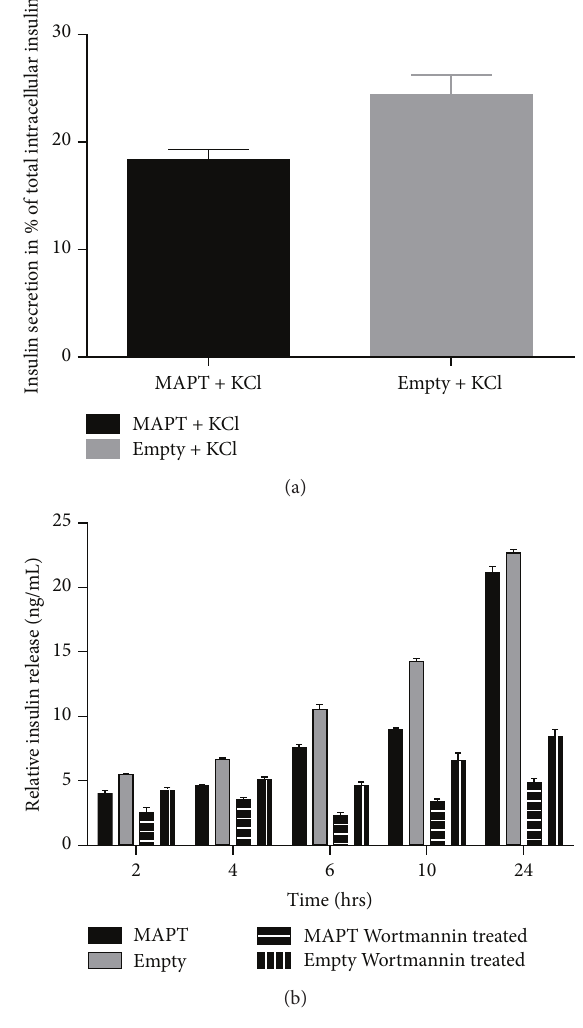
Figure 7: Insulin secretion. (a) Insulin secretion after stimulation for 2h with 20mM KCl. Insulin secretion from MAPT overexpress- ing cells versus Empty was calculated in the percentage of total intracellular insulin content; 𝑝 < 0.05 . (b) MAPT overexpressing Rin-5F cell line versus Empty over a time period of 24 hours. Cell lines were either grown in RMPI 1640 medium or in RMPI 1640 medium supplemented with 1 𝜇 M Wortmannin. Each column representing relative insulin secretion level is obtained for respective cell line as described in the legend attached directly to the graph. The insulin secretion was normalized to the total intracellular insulin content. Data is presented from 3 independent experiments ±